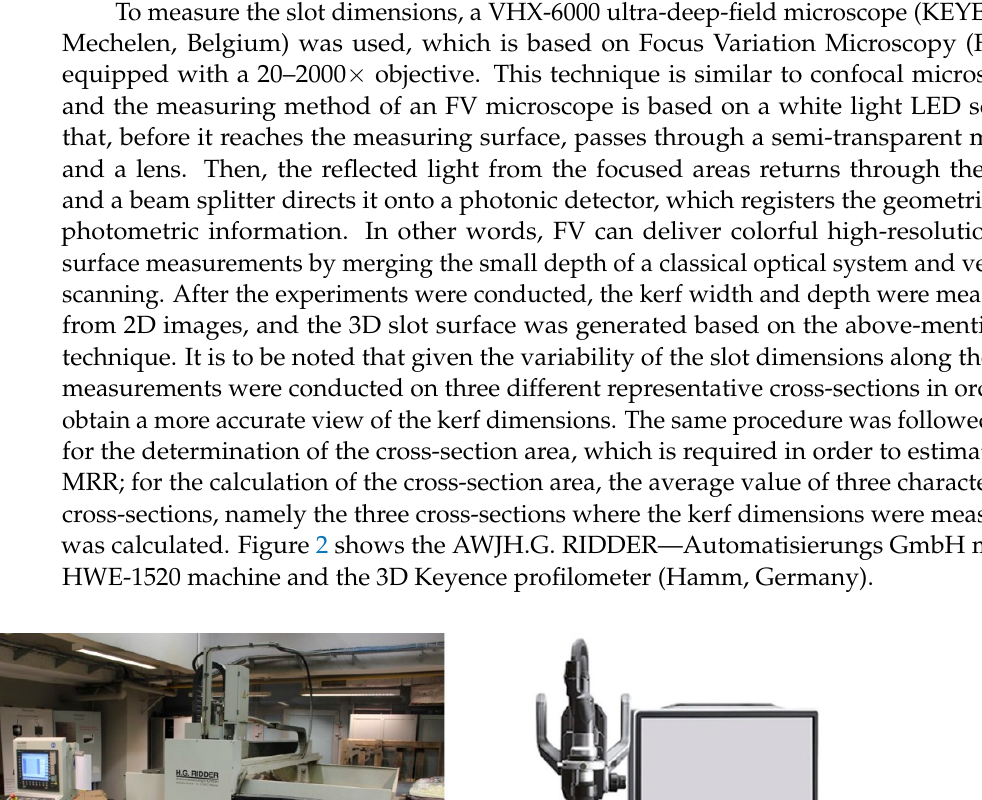
Figure 1. Schematic of the Abrasive Waterjet (AWJ) milling setup showing an SEM image of the garnet particles and the basic geometric characteristics of the slots.